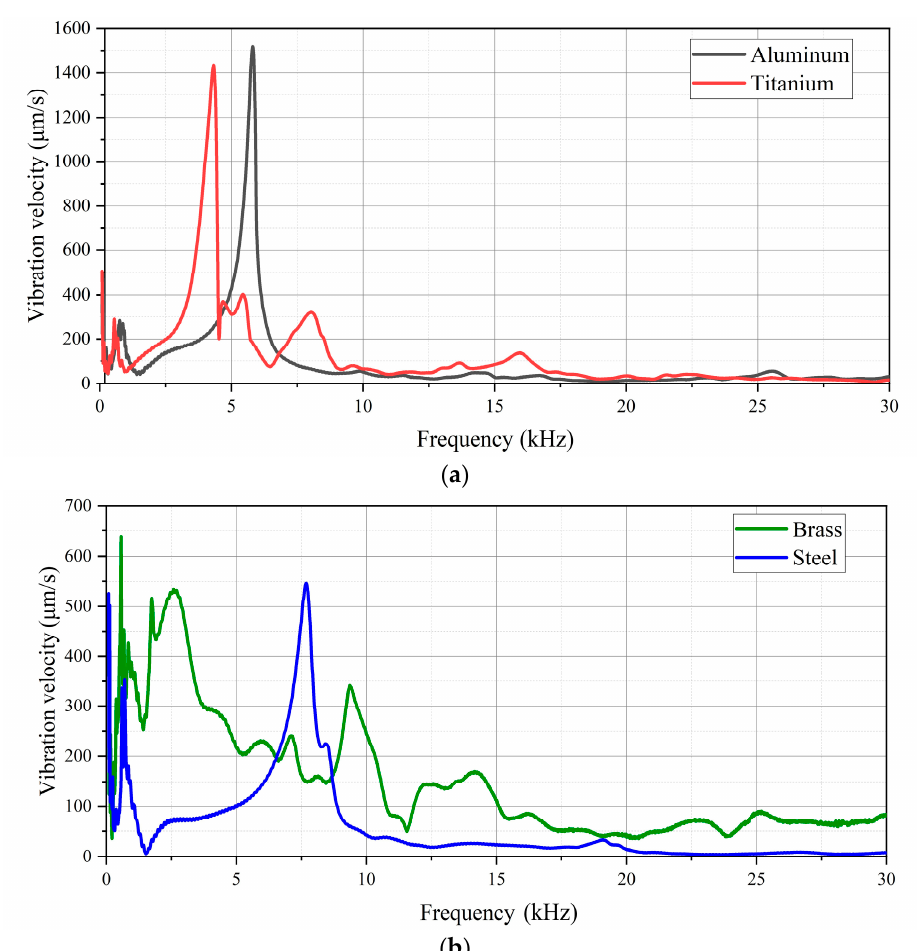
Figure 6. Amplitude–frequency spectrum of 2 mm thick metallic membranes (aluminum and titanium ( a ); brass and steel ( b )).